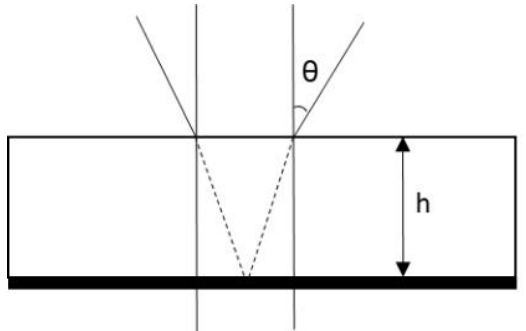
Figure 3. The calculation of optical path difference.